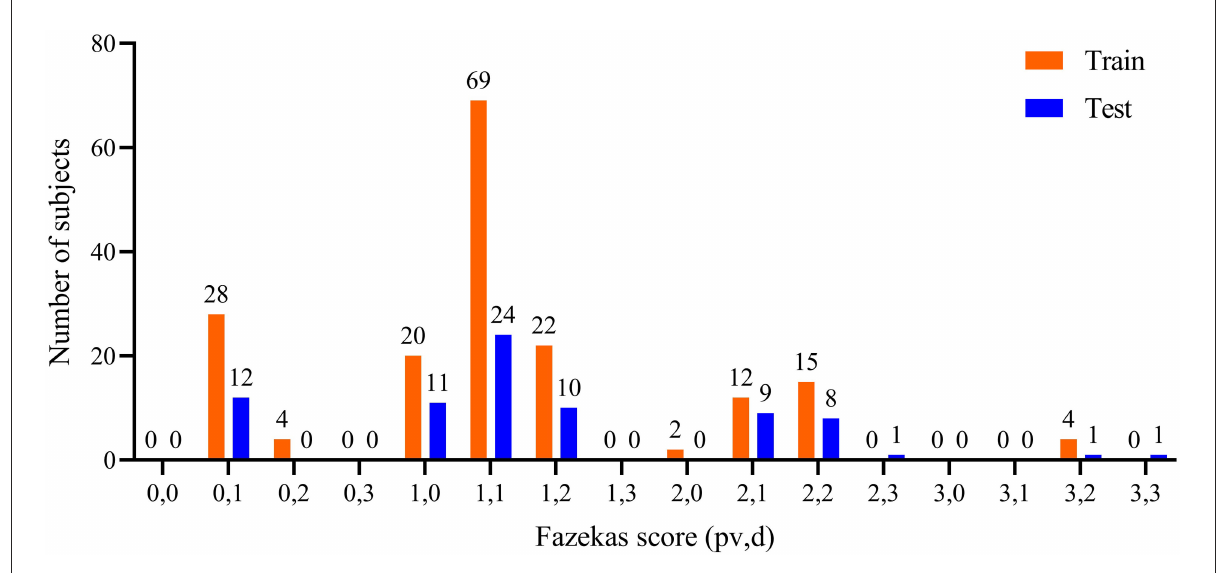
FIGURE1 Distribution of pvWMHs and dWMHs Fazekas scores. pv represented Fazekas scores of pvWMHs, and d represented the Fazekas scores of